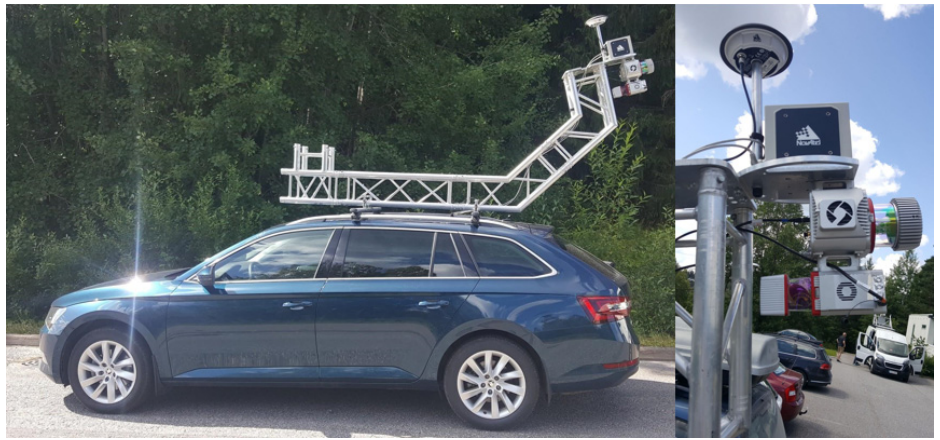
Figure 3. Roamer-R4DW system is a vehicle-mounted mobile laser scanning (MLS) system for road environment mapping. The unit offers unique dual-wavelength sampling of objects. In the image on the right, the Global Navigation Satellite System (GNSS) antenna is on top, with the inertial measurement unit (IMU) and VUX-1HA and miniVUX-1UAV scanners back-to-back to provide cross-track scanning over the road surfaces. The system could also be fitted with a panoramic camera for georeferenced images.